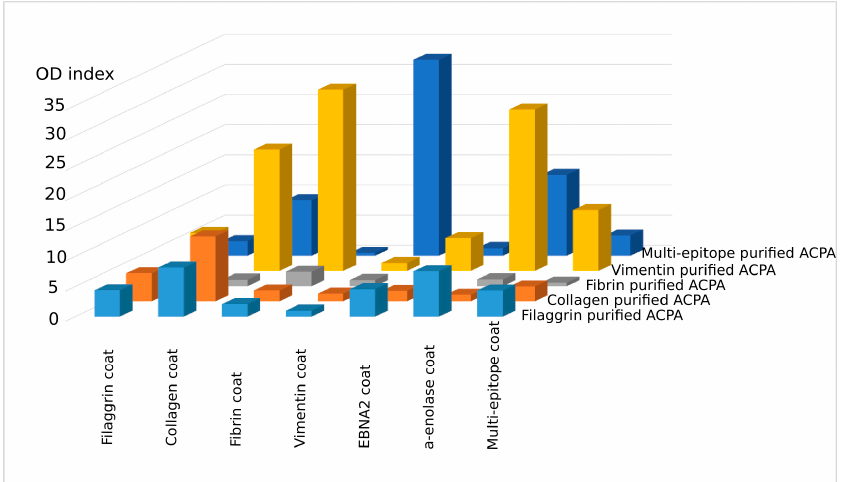
Figure 2. Reactivity of affinity-purified IgG fractions with the relevant and irrelevant citrulline- containing peptides. OD ratios that are OD with Cit/OD with Arg-containing peptides are shown. Cut-off values for each Cit- and Arg-containing peptide pair were calculated from OD indexes of 120 healthy samples (the means of OD indexes + 2 × SD). These were below 1.5 for all peptides. Results of a typical experiment.